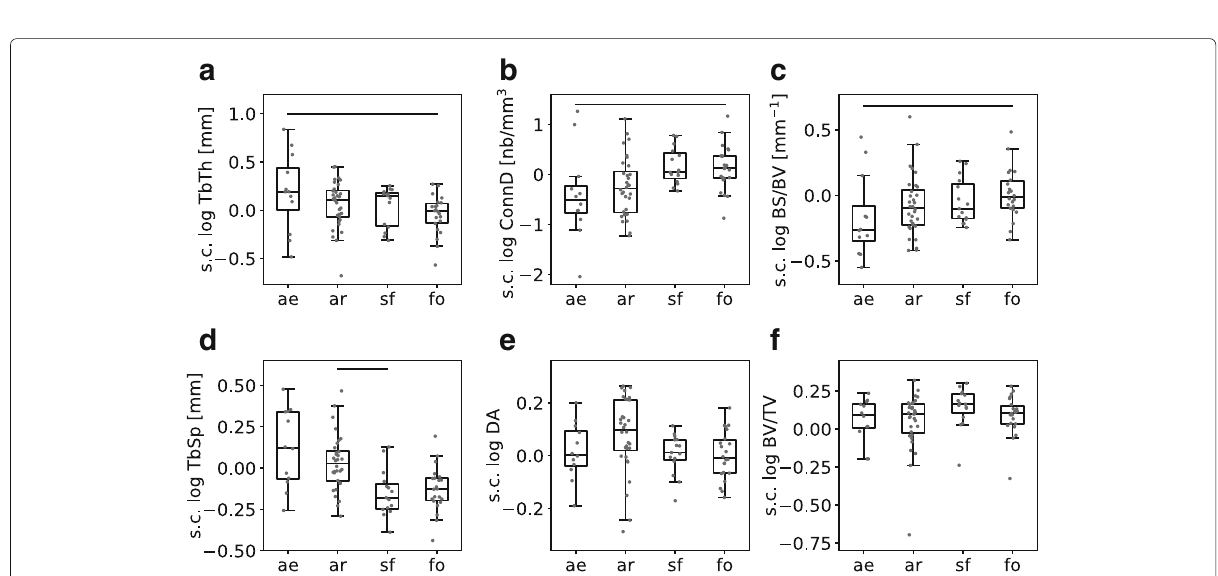
Fig. 5 Lifestyle-related adaptations of trabecular parameters. The boxplots illustrate distributions of the size-corrected (s.c., residuals after allometry regression) data of the trabecular parameters in the lifestyle groups aerial ae , arboreal ar , semifossorial sf and fossorial fo . Significant differences between groups, as revealed by phylogenetically informed regression, are indicated by the horizontal lines ( p -values were corrected for multiple testing, for detailed explanation see text). a-c Aerial species are distinguished from fossorial ones by a higher trabecular thickness TbTh , lower connectivity density ConnD and lower bone surface density BS/BV . d Trabecular separation TbSp is higher in arboreal species than in semifossorial ones. e-f Degree of anisotropy DA and bone volume fraction BV/TV do not show significant functional